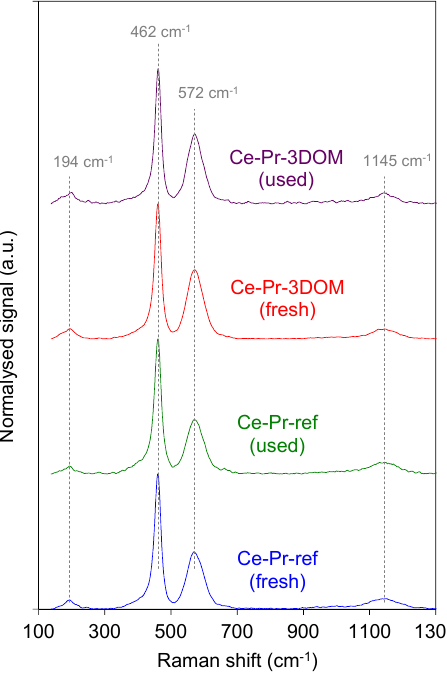
Figure 4. Raman spectroscopy characterization of the fresh and used catalysts.